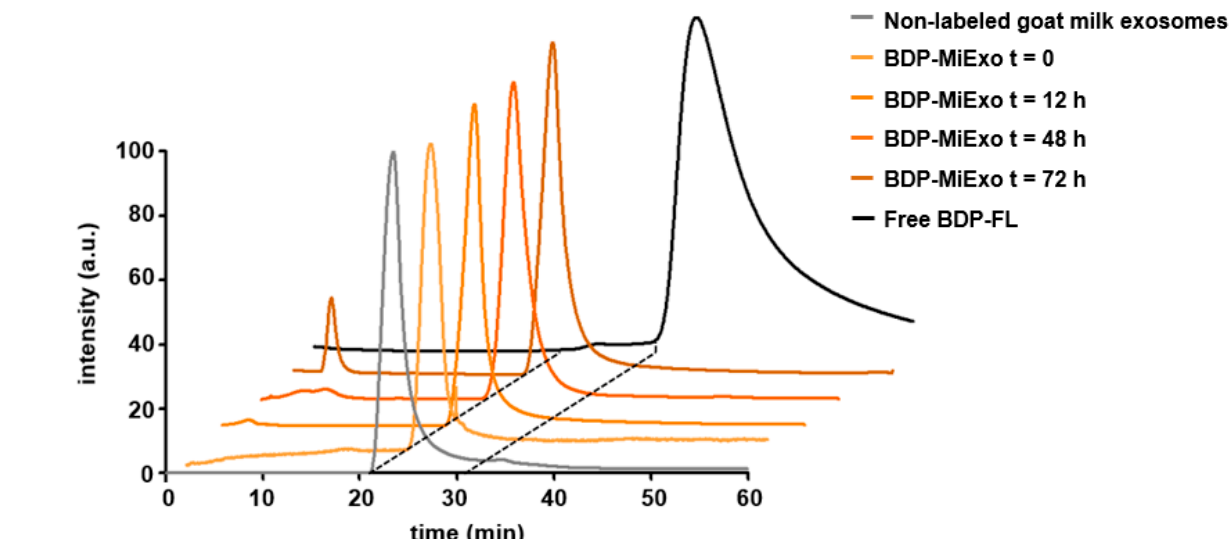
Figure 3. In vitro stability of Bodipy FL-labeled milk exosomes (BDP-MiExo) over time, evaluated with high performance liquid chromatography.